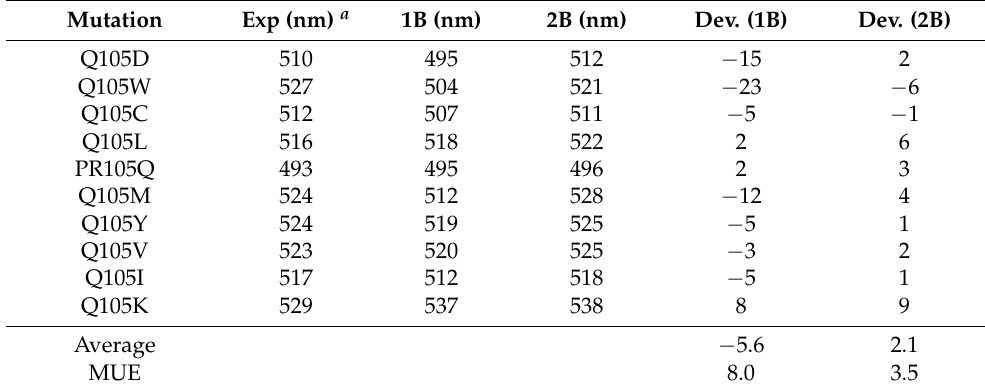
Figure 4. The correlation between the experimental absorption wavelengths of different mutations of PR105Q and calculated results using EE-GMFCC. The 1B and 1B + 2B results are both provided. ( a ) 1B: only the one-body QM interactions are included. ( b ) 1B + 2B: both the one-body and two-body QM interactions are included (see Equation (4)). 1B and 2B represent the excitation energy contributions from the covalently-linked three neighboring residues, and the two non-covalently-linked residues that are spatially in close contact, respectively. Table 1. Calculated excitation energy using EE-GMFCC at the TD-B3LYP/6-31G* level for different mutations of PR. “Dev.” stands for the deviation from the experimental value. 1B and 2B denote the excitation energy calculated by 1B correction, and 1B + 2B corrections, respectively. 1B and 2B represent the excitation energy contributions from the covalently-linked three neighboring residues, and the two non-covalently-linked residues that are spatially in close contact, respectively. MUE denotes the mean unsigned